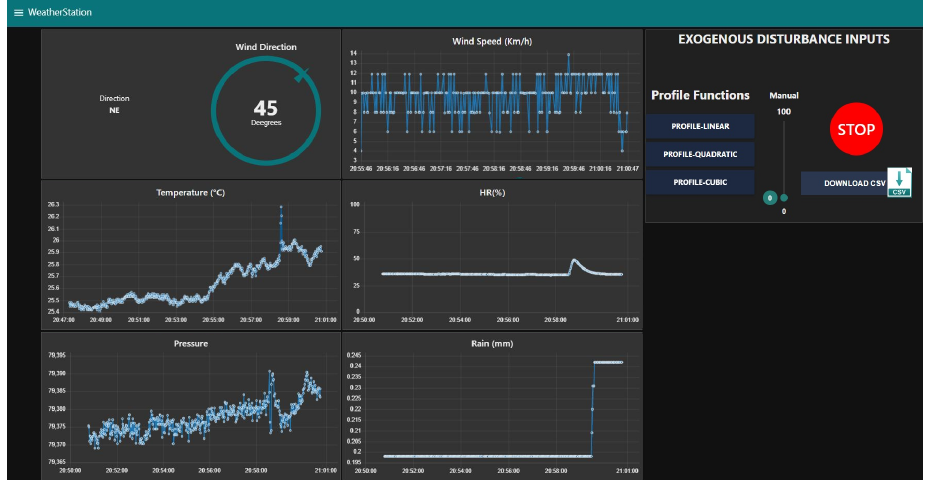
Figure 9. GUI-MEIoT 2.0 on